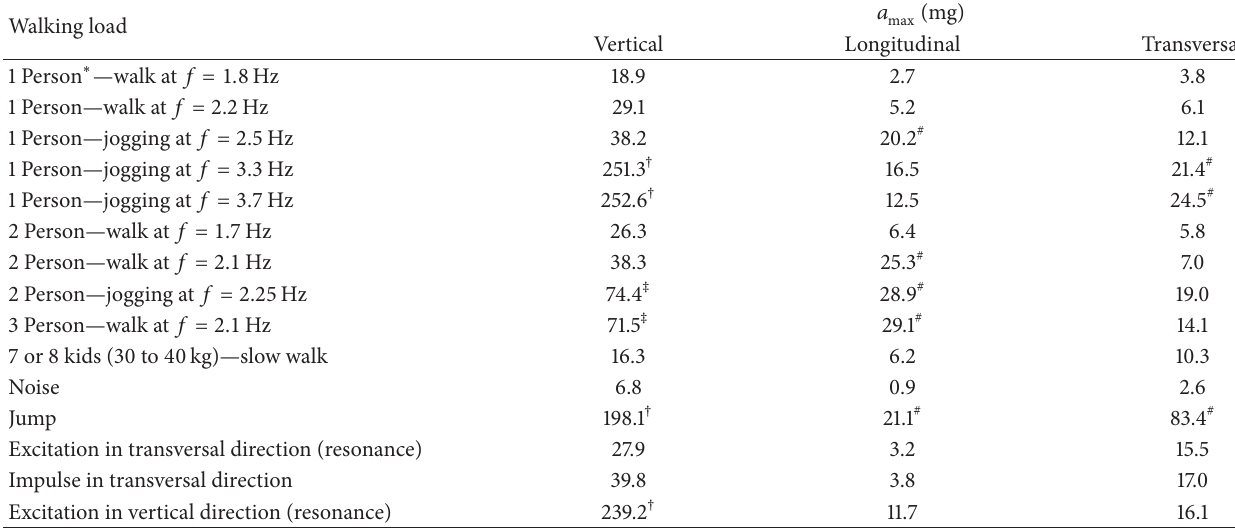
Table 6: Peak acceleration amplitudes for different tests.